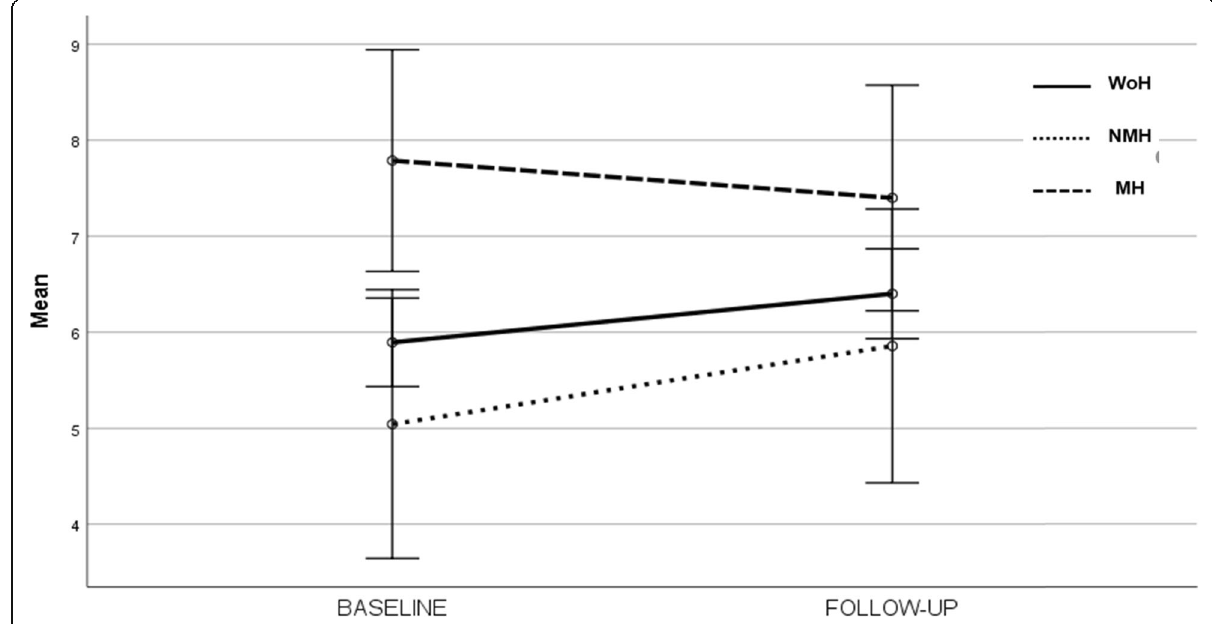
Fig. 2 Cognitive complaints scores by headache group. Legend: y-axis represent estimated marginal means of Subjective Memory Complaints Questionnaire scores controlling for age and depressive symptoms; WoH – without headache, NMH – non migraine headache, MH – migraine headache